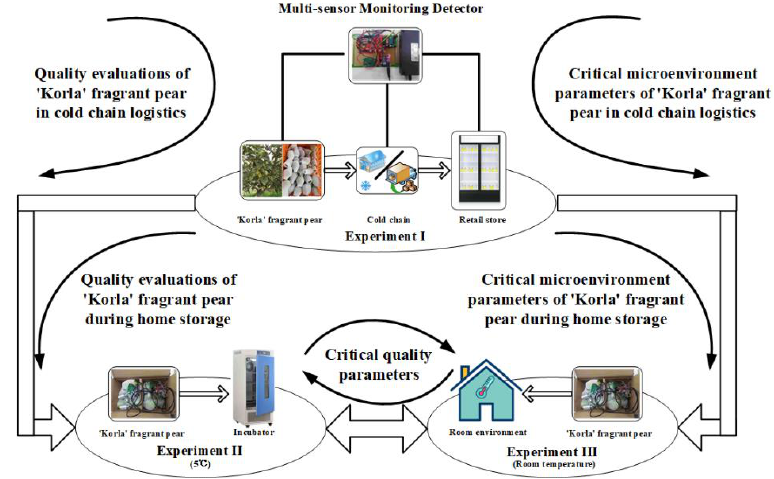
Figure 3. The diagram of the experiments.